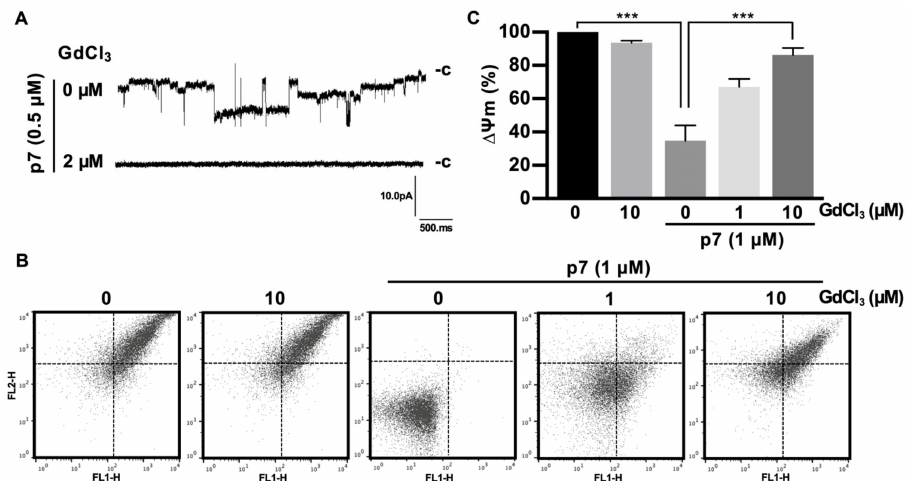
Figure 5. Inhibitory e ff ects of GdCl 3 on the channel activity of p7 in planar bilayer recordings and on p7-induced mitochondrial depolarization. ( A ) GUVs composed of DphPC:DOPS:cholesterol, 85:5:10 (mol / mol), were electroformed and used to form the bilayer. p7 was diluted with 1 M sorbitol (final concentration of p7 = 0.5 µ M) and applied to the preformed bilayer, and then macroscopic currents were recorded. Inhibitory e ff ects of the indicated concentration of GdCl 3 on the macroscopic currents were recorded. ( B , C ) The mitochondria isolated from the mouse liver were incubated with the indicated concentration of GdCl 3 for 10 min, followed by incubation with 1 µ M of p7 for another 10 min, after which mitochondria were stained with JC-1 for 15 min. Mitochondrial membrane potential was recorded with flow cytometry ( B ) and quantified ( C ). Data are presented as the mean ± SD and analyzed with 3-way ANOVA. *** p ≤